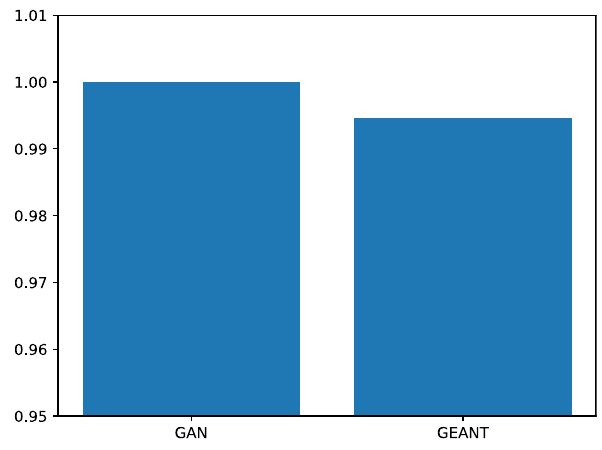
Fig. 22 Predicted particle type (electron vs. charge pions) for GAN and GEANT images. There were 2213 electron events for each type